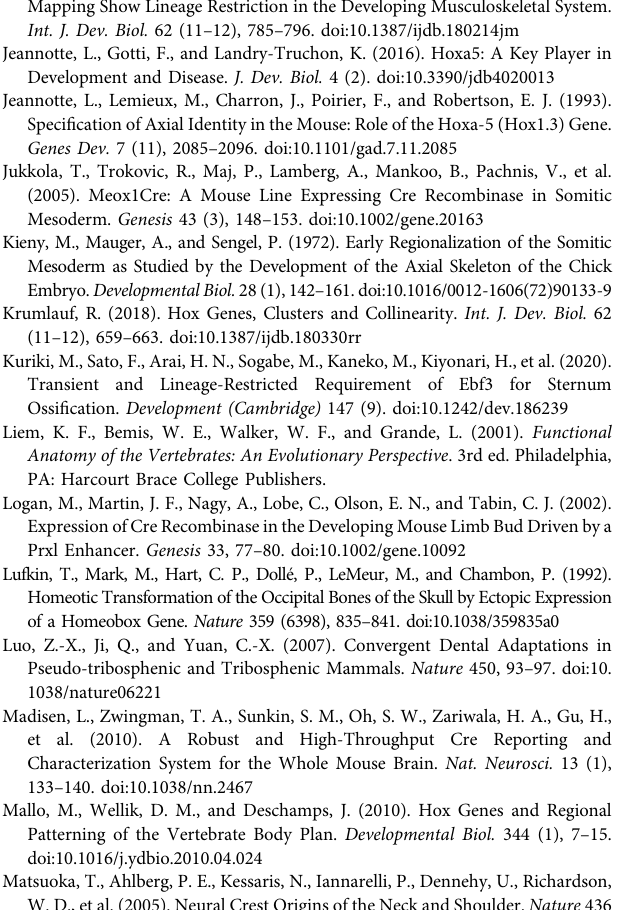
and EBF3 are co-expressed in lateral domain ( B ′ , yellow cells). Orange arrows in (A,B) point to HOXA5 lateral domain that does not co-express with SOX9, and corresponds to region indicated in ( Supplementary Figure S3C ). IC, interclavicular mesenchyme; ICC, intercostoclavicular mesenchyme; PM, pectoral muscle. Scale bar: 200 μ